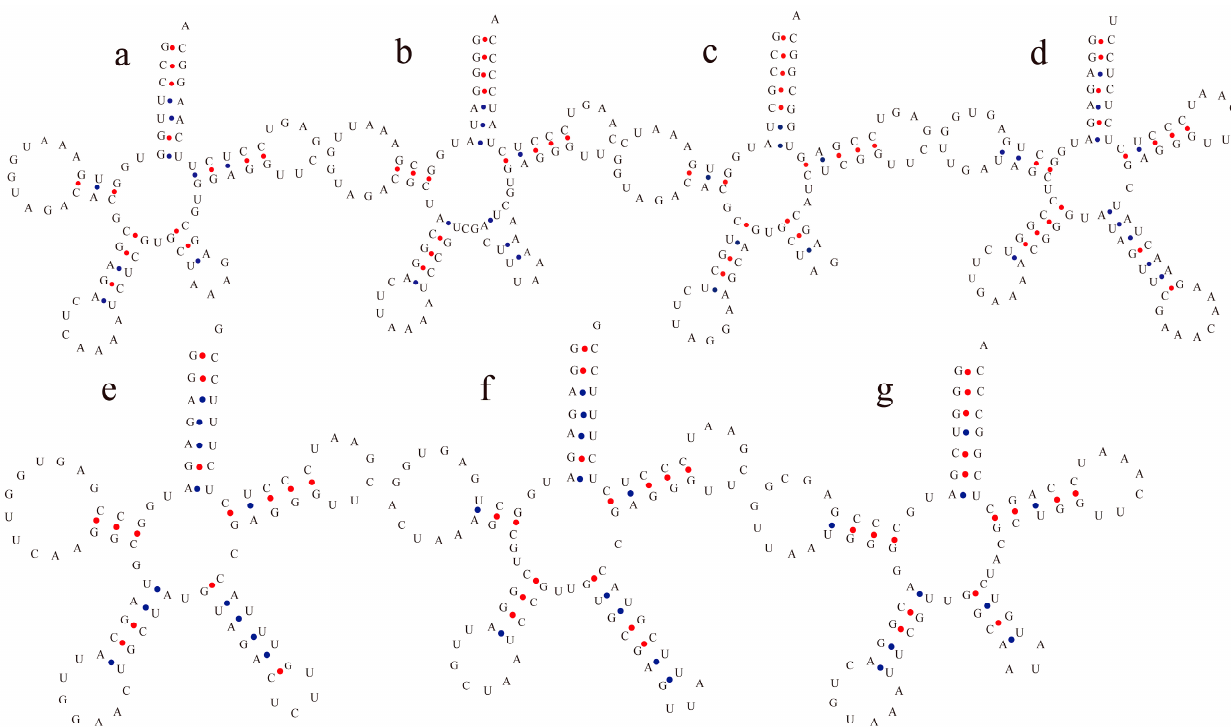
Figure 4. Structures of the chloroplast tRNAs showed the presence of a loop structure in the variable region: ( a – c ) tRNA Leu ; ( d – f ) tRNA Ser ; ( g ) tRNA Tyr . Anti-codon loop had seven nucleotides with the conservative X-U-X3-A-A consensus sequence in these tRNAs. Loop structure of the variable region was observed to contain three to eight nucleotides from tRNA Leu , tRNA Ser , and tRNA Tyr .